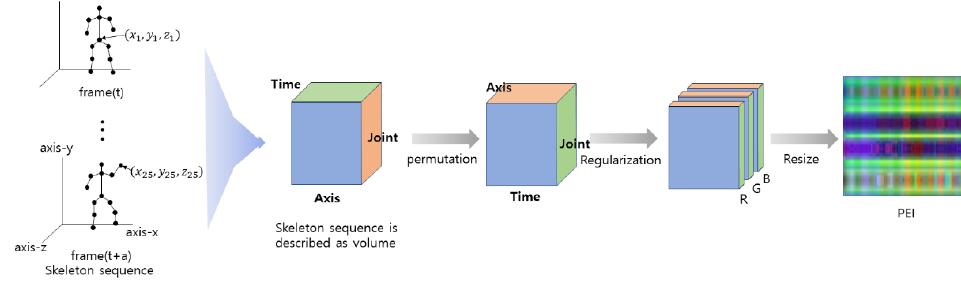
Figure 1. Diagram of the PEI transform.